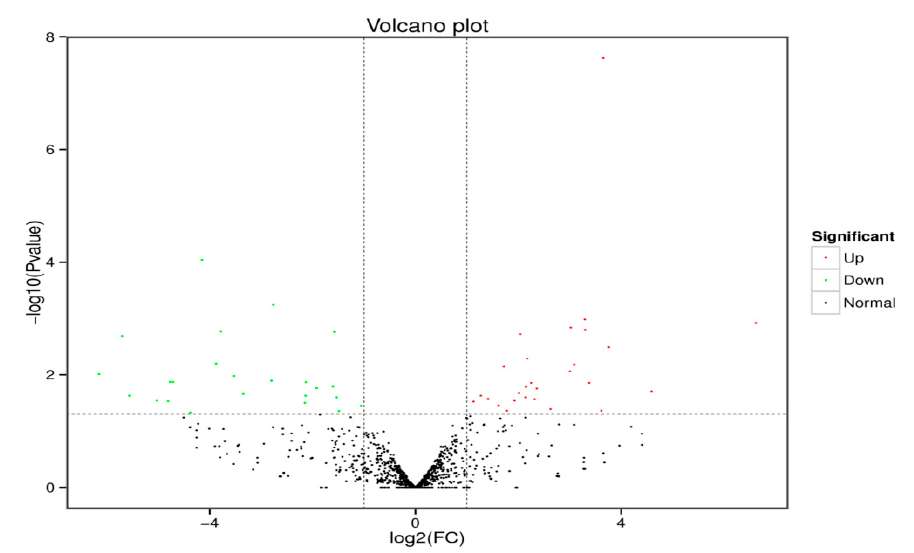
Figure 2. Volcano plot of the differentially expressed miRNAs in the CS and CON groups.